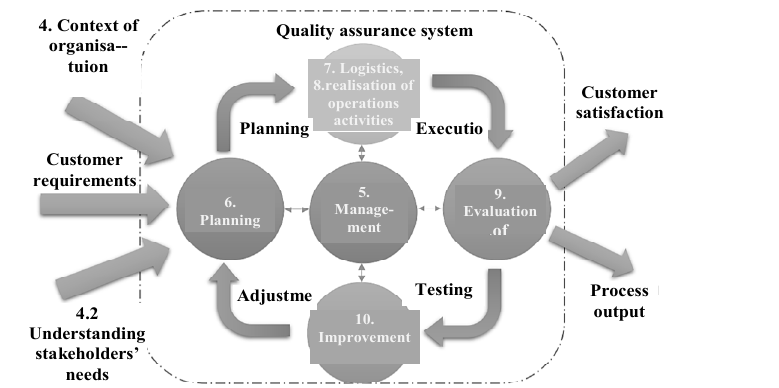
Figure 3 – Relations between the QMS subsystem and ISO 9001: 2015 standard Рис . 3 – Схема подсистем QMS и ISO 9001: 2015 Слика 3 – Шема подсистема QMS према стандарду ISO